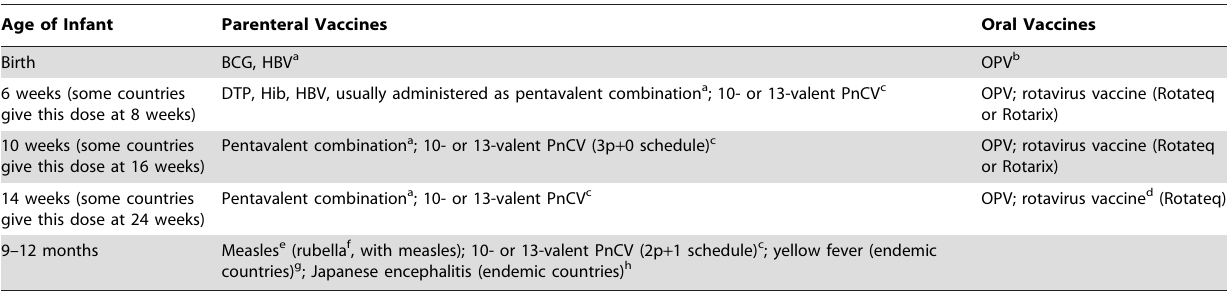
Table 4. World Health Organization–recommended EPI schedule, 2012.